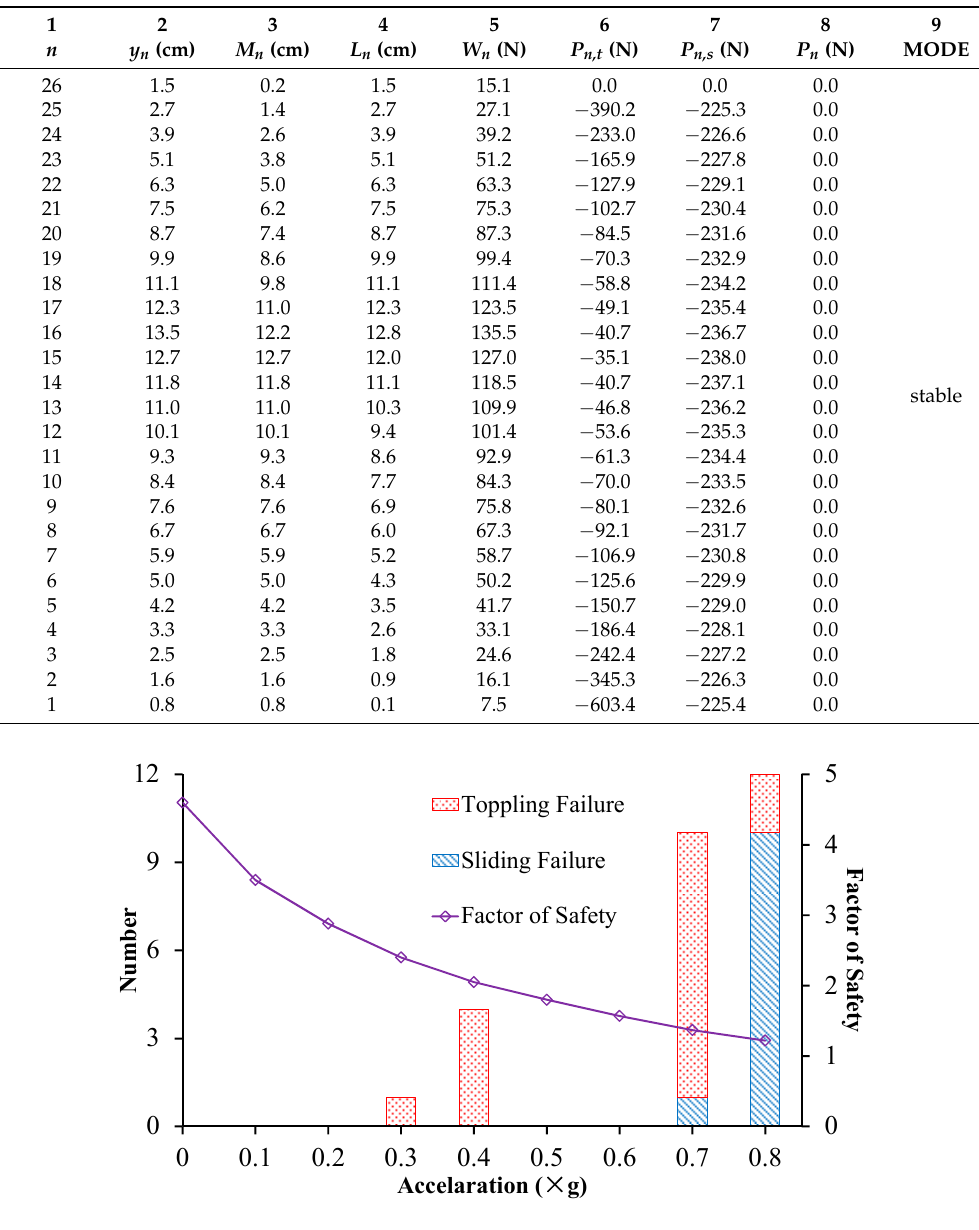
Figure 8. The deformation blocks and factor of safety (FOS) of the slope during the shake table test. (Accelerations in horizontal axis denote k x with k y = 0, and k x = k y = 0.3 g is excluded in this diagram). Table 3. The sheet from limit equilibrium analysis of slopes under static state.